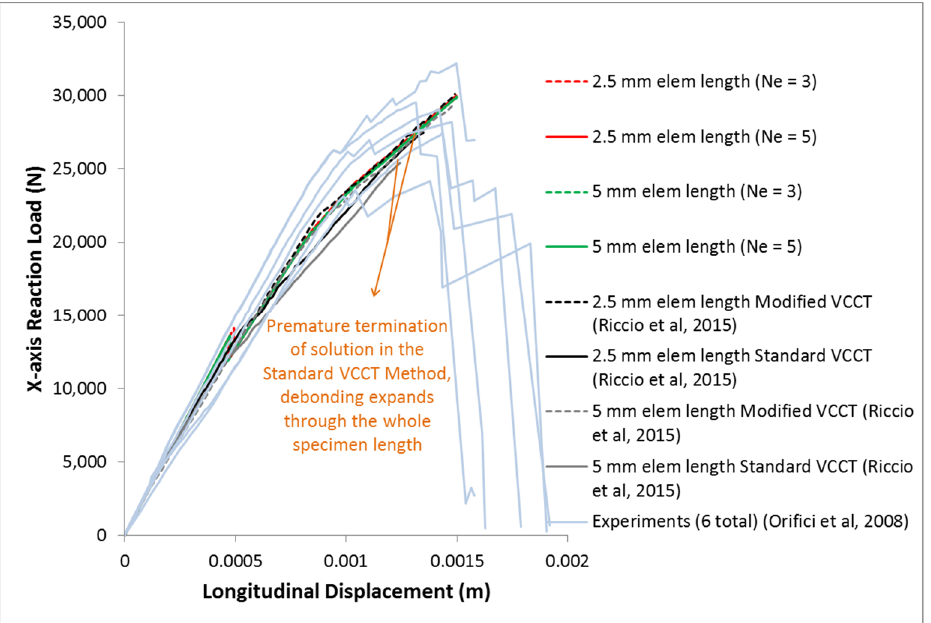
Figure 4. Comparison of the load–displacement curves for SOLSH190 when modified CZM is applied, with experimental and numerical from the literature.